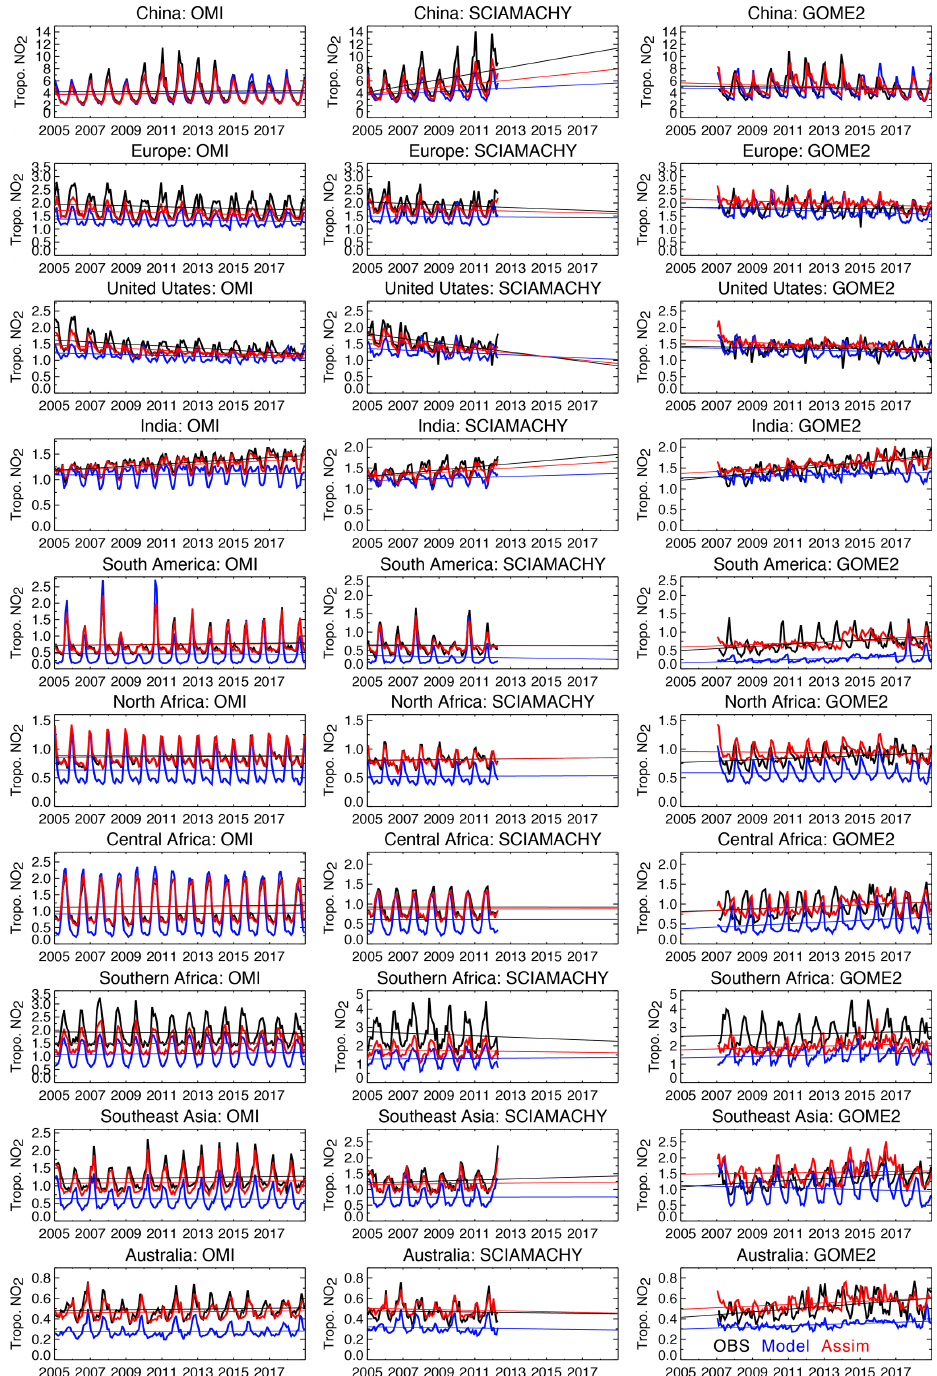
Figure 6. Time series of regional monthly mean tropospheric NO 2 columns (in 10 15 molec . cm − 2 ) averaged over China (110–123 ◦ E, 30– 40 ◦ N), Europe (10 ◦ W–30 ◦ E, 35–60 ◦ N), the US (70–125 ◦ W, 28–50 ◦ N), India (68–89 ◦ E, 8–33 ◦ N), South America (50–70 ◦ W, 20 ◦ S– Equator), northern Africa (20 ◦ W–40 ◦ E, Equator–20 ◦ N), central Africa (10–40 ◦ E, Equator–20 ◦ S), southern Africa (25–34 ◦ E, 22–31 ◦ S), southeastern Asia (96–105 ◦ E, 10–20 ◦ N), and Australia (113–155 ◦ E, 11–44 ◦ S) obtained from the satellite retrievals (black), the control run (blue), and data assimilation (red). Results are shown for the OMI retrievals (left column), SCIAMACHY retrievals (center column), and GOME-2 retrievals (right